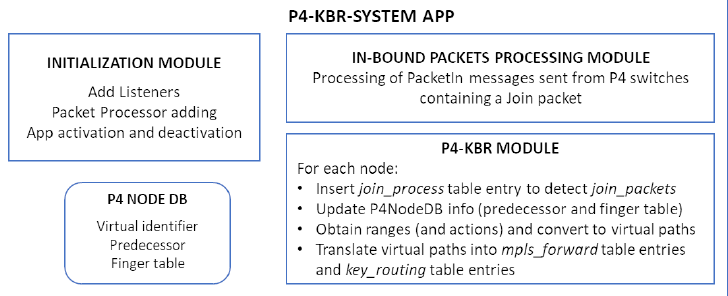
Figure 6. Description of the pipeline-aware P4-KBR-SYSTEM